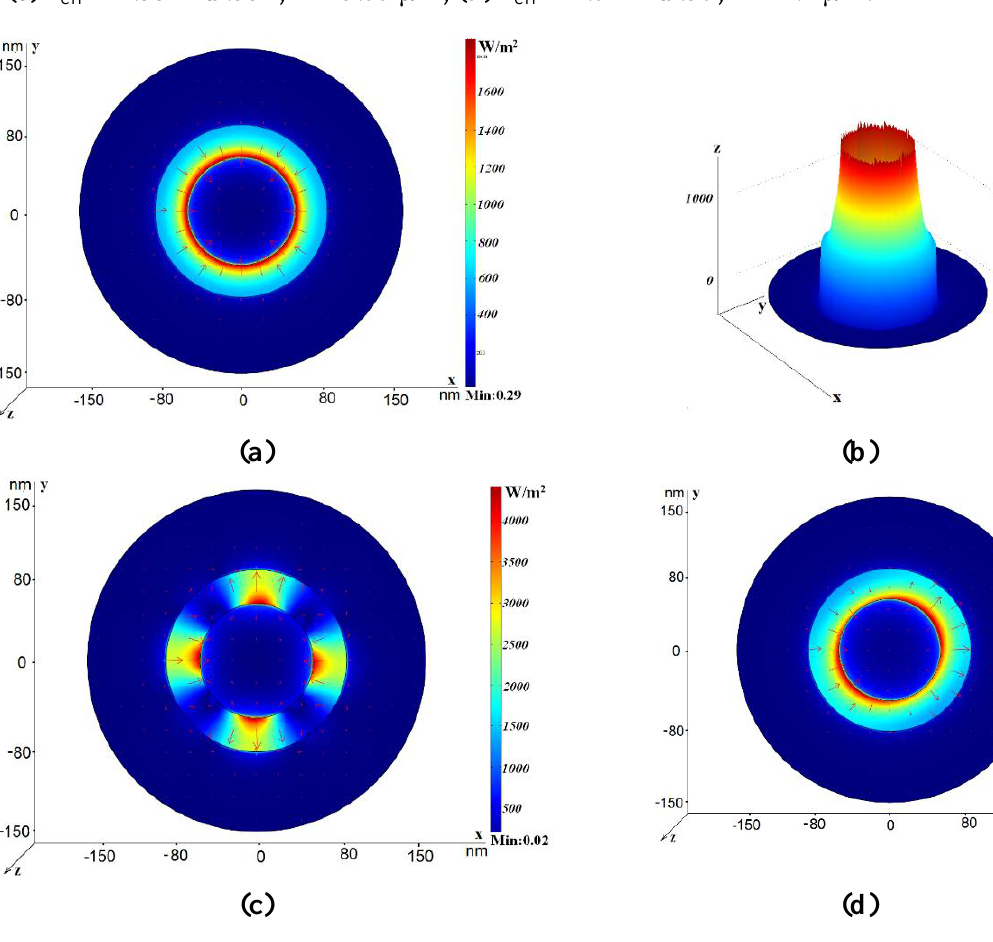
Figure 3. Power flow distribution for the various modes in the case r h = 70 nm, R = 150 nm. The electric field vector is shown by arrows. ( a ) n 2 out L = 1.32  m; ( b ) Three-dimensional power flow distribution for the same waveguide; ( c ) n = 1.33 + i 0.057, L = 0.69  m; ( d ) n eff